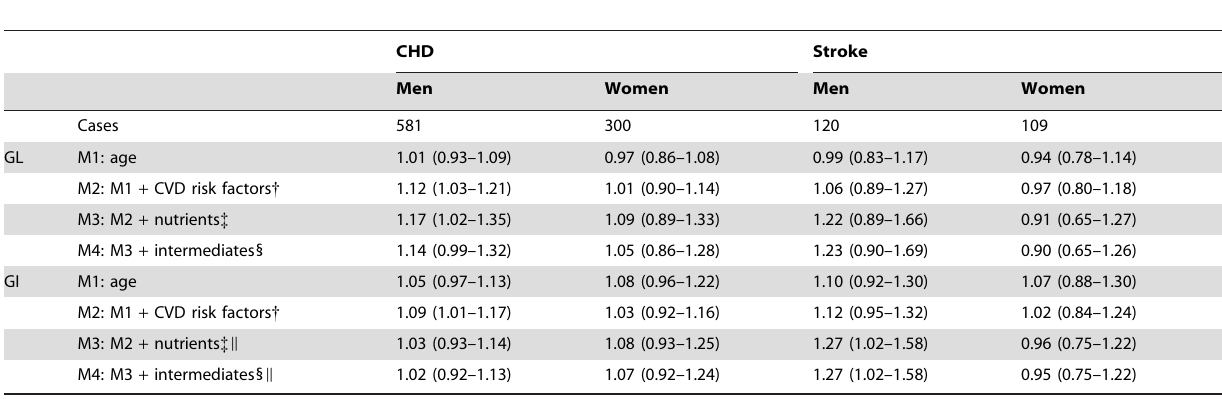
Table 2. Glycemic Load, Glycemic Index, and the Risks of Coronary Heart Disease and Stroke Among 8,855 Men and 10,753 Women*.